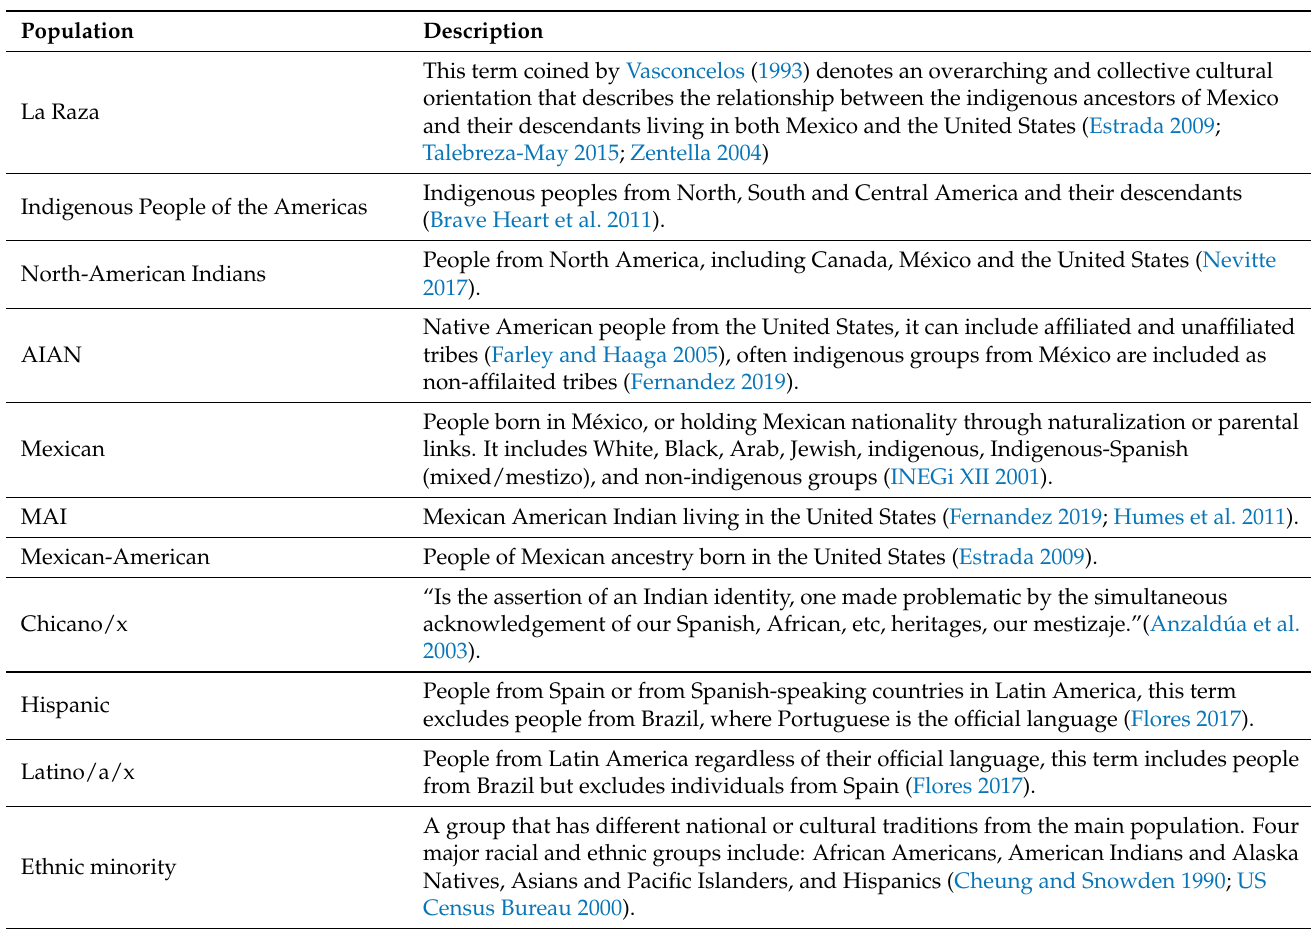
Table 3. Descriptions of populations that intersect